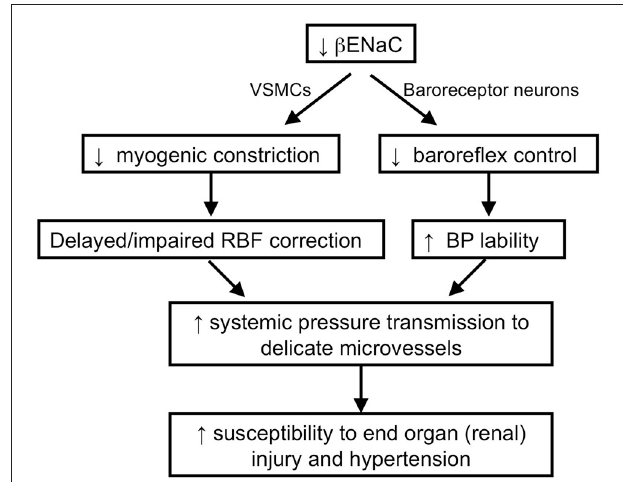
FIGURE 7 | Schematic of working hypothesis: the role of β ENaC as a mechanosensor and its role in cardiovascular pathophysiology. We hypothesize that β ENaC is a critical component of mechanosensors in renal VSMCs and arterial baroreceptor neurons. Loss in β ENaC function in renal VSMCs leads to a loss in renal myogenic constriction and a delayed or impaired correction of renal blood flow following upward swings in blood pressure. Loss in β ENaC function in arterial baroreceptor neurons leads to a loss in baroreflex control of blood pressure and increased BP lability. Increased BP lability and decreased myogenic constriction increase the opportunities and magnitude of systemic pressure transmission to the renal microvessels, which in turn, increases susceptibility to end-organ injury and